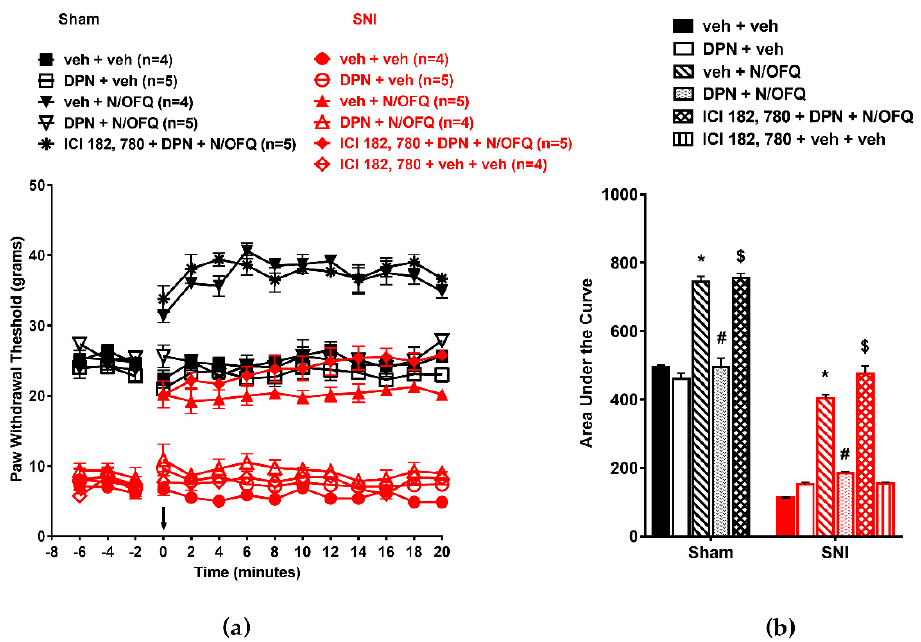
Figure 6. Selective activation of ER β in male rats rapidly attenuated NOP-mediated antihypersensitivity: ( a ) SNI significantly reduced PWTs compared to the sham group. N / OFQ (10 nM) increased PWTs in both the sham and SNI groups. DPN (100 nM) abolished the N / OFQ-induced increase in PWTs. Pretreatment with mER antagonist (ICI 182,780) restored an N / OFQ-induced increase in PWTs. ( b ) AUC analysis confirmed these e ff ects, with a significantly reduced AUC in SNI groups, N / OFQ significantly increasing it, and DPN attenuating the e ff ect of N / OFQ in an antagonist-reversible manner.